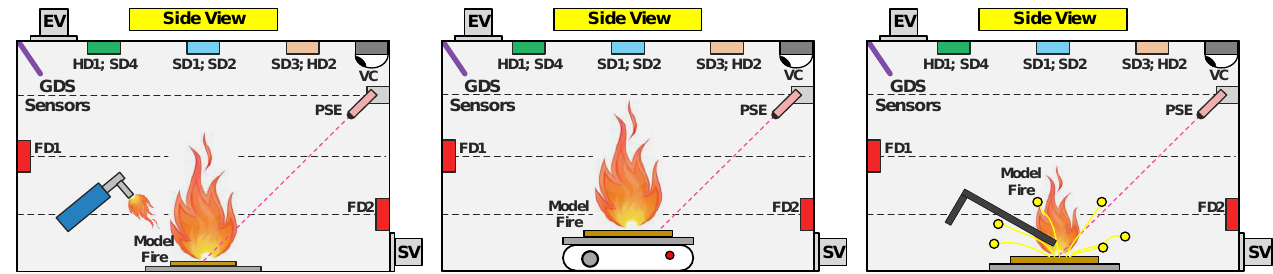
Figure 1. Setup layout illustrating three different ways used to start a model fire burning (heat detector – HD, smoke detector – SD, video camera – VC, pyrometer sensing element – PSE, flame detector – FD, gas detection system – GDS, exhaust ventilation – EV, supply ventilation – SV).